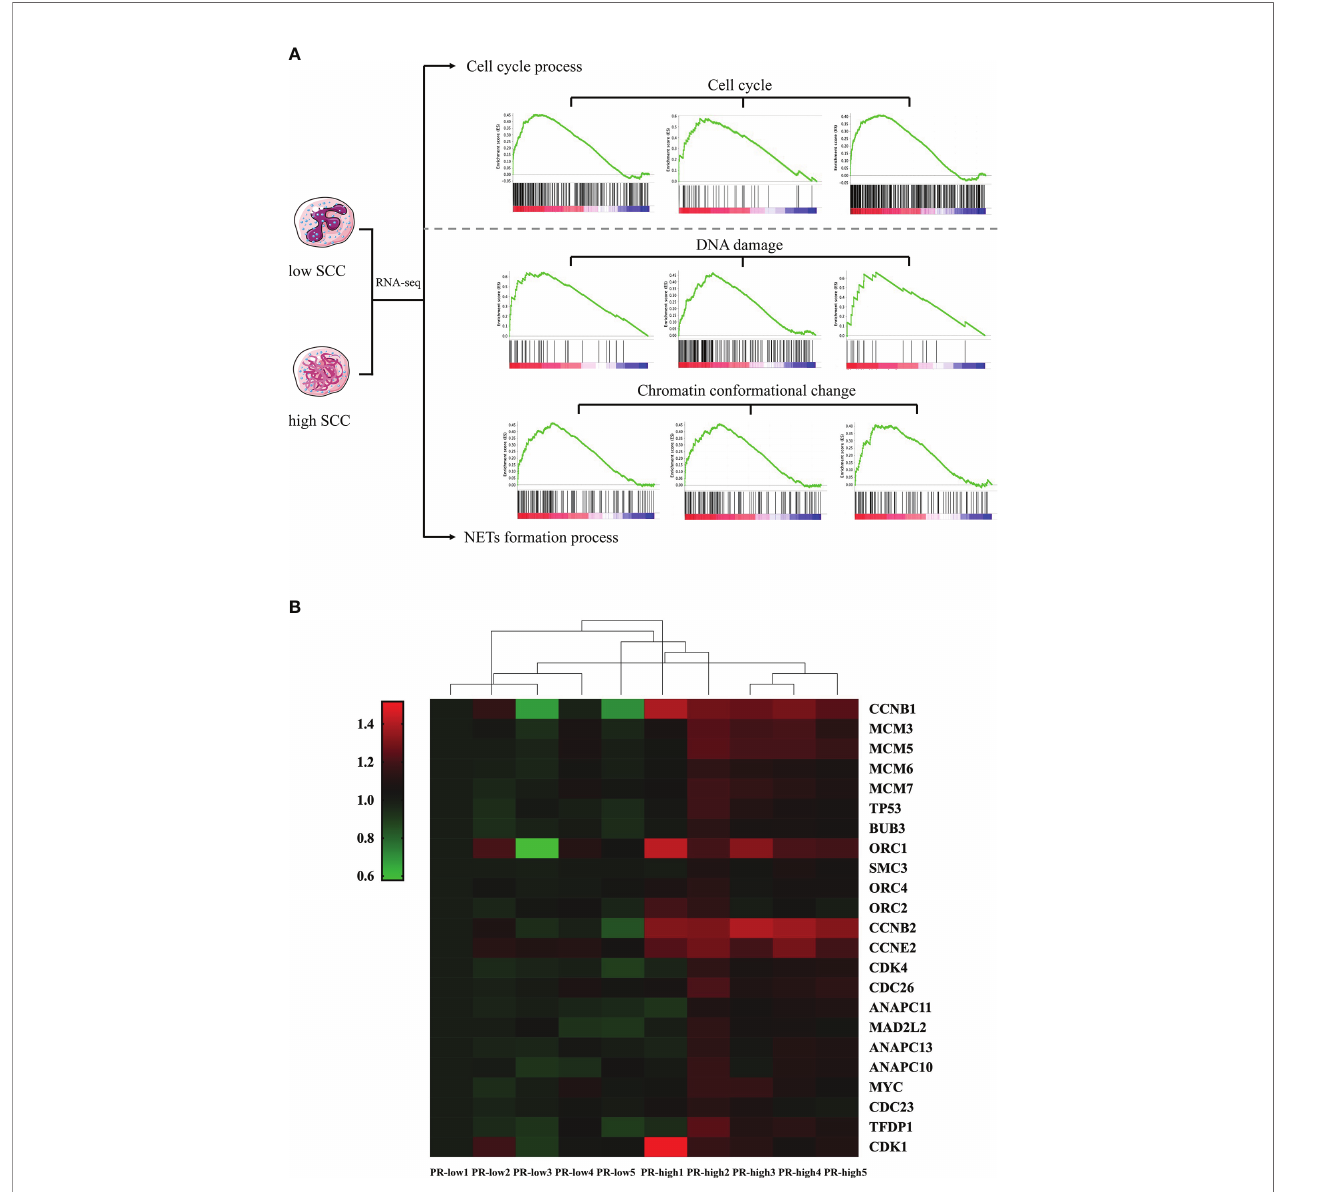
FIGURE 5 | Gene set enrichment analysis (GSEA) of differentially expressed genes (DEGs) in neutrophils from dairy cows with high or low somatic cell counts at Week 1 prepartum. (A) The cell cycle, DNA damage, and chromatin conformational pathways identi fi ed by GSEA. (B) Heatmap showing hub DEGs in the cell cycle, DNA damage, and chromatin conformational pathways. PR-low, prepartum low SCC; PR-high, prepartum high